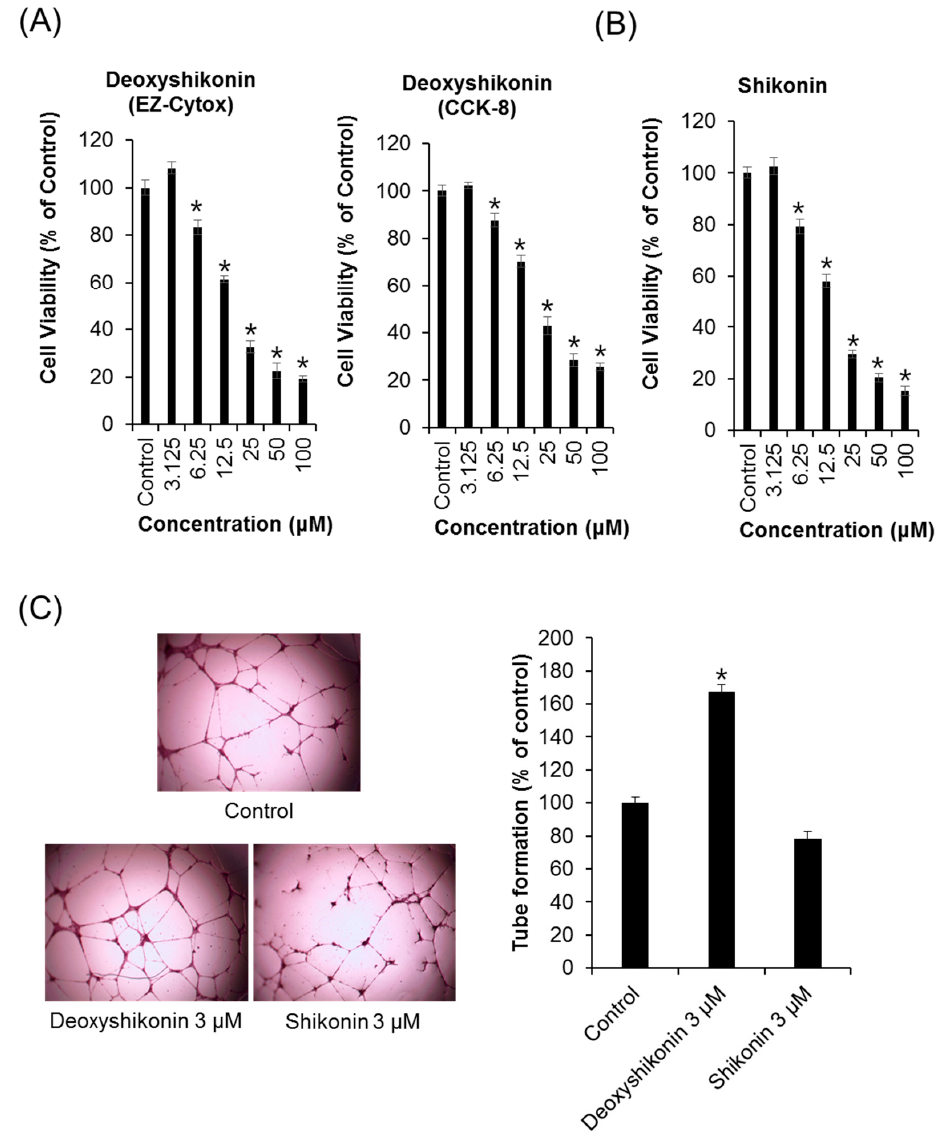
Figure 2. The effects of deoxyshikonin and shikonin on HUVEC proliferation and tube formation. ( A , B ) Cells were treated with deoxyshikonin and shikonin at a series of concentrations (3.125–100 µM) or the DMSO vehicle (control) for 24 h, followed by evaluating cell viability and proliferation using EZ-Cytox and CCK-8 (Cell Counting Kit-8) assay kits, respectively. ( C ) Tube formation of HUVECs on Matrigel after incubation with or without 3 µM deoxyshikonin or shikonin after 24 h. The relative lengths of tubes were measured using the ImageJ software. Data are expressed as means ± SEM. Similar results were obtained in three independent experiments; * p < 0.05 compared to the control